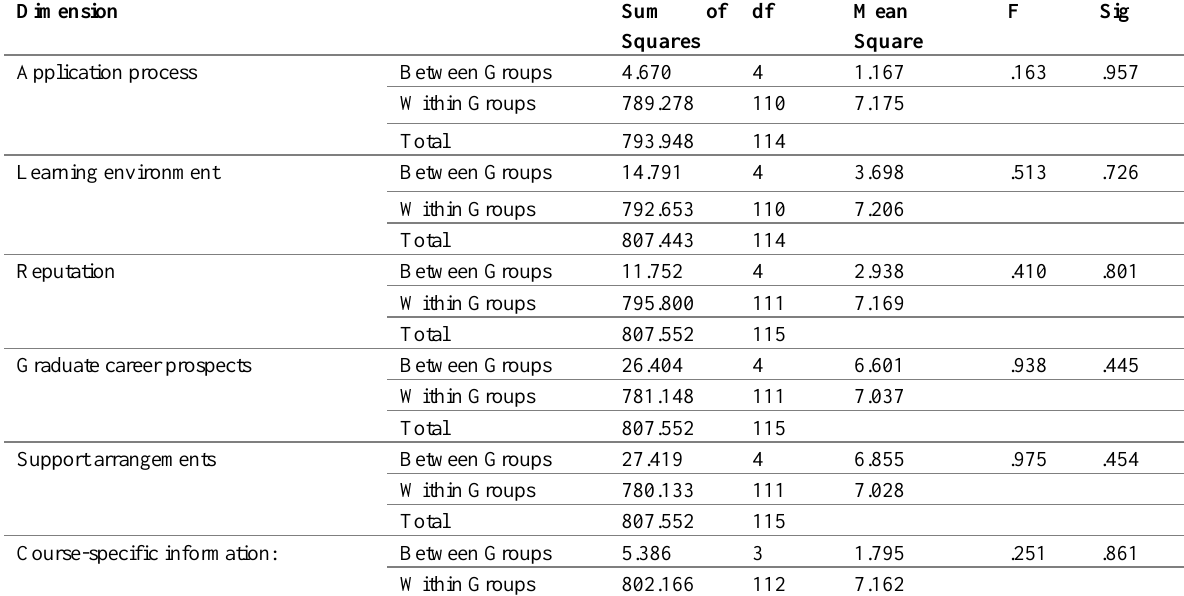
Table 5: ANOVA comparison between-subject effects of field of study and information needs